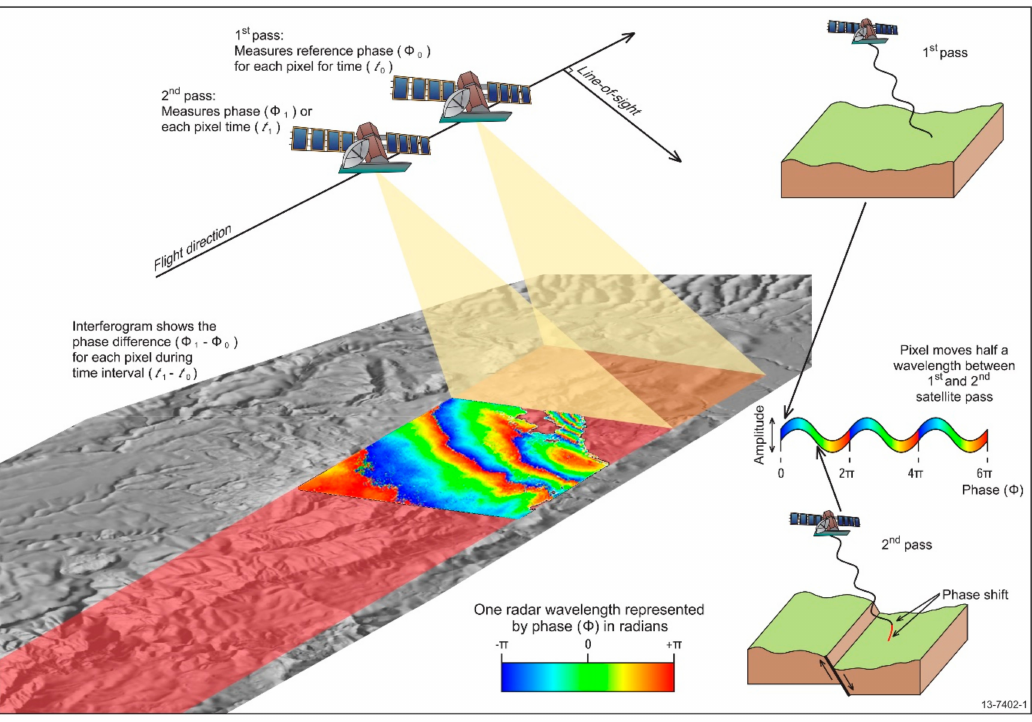
Figure 16. Illustration of the technical principles of InSAR-based land subsidence remote sensing. Two SAR images of the same area are acquired at di ff erent times by a satellite. If the surface moves between the two acquisitions a phase shift is recorded. An interferogram maps this phase shift spatially. (Adapted with permission from Commonwealth of Australia (Geoscience Australia) 2019. This product is released under the Creative Commons Attribution 4.0 International